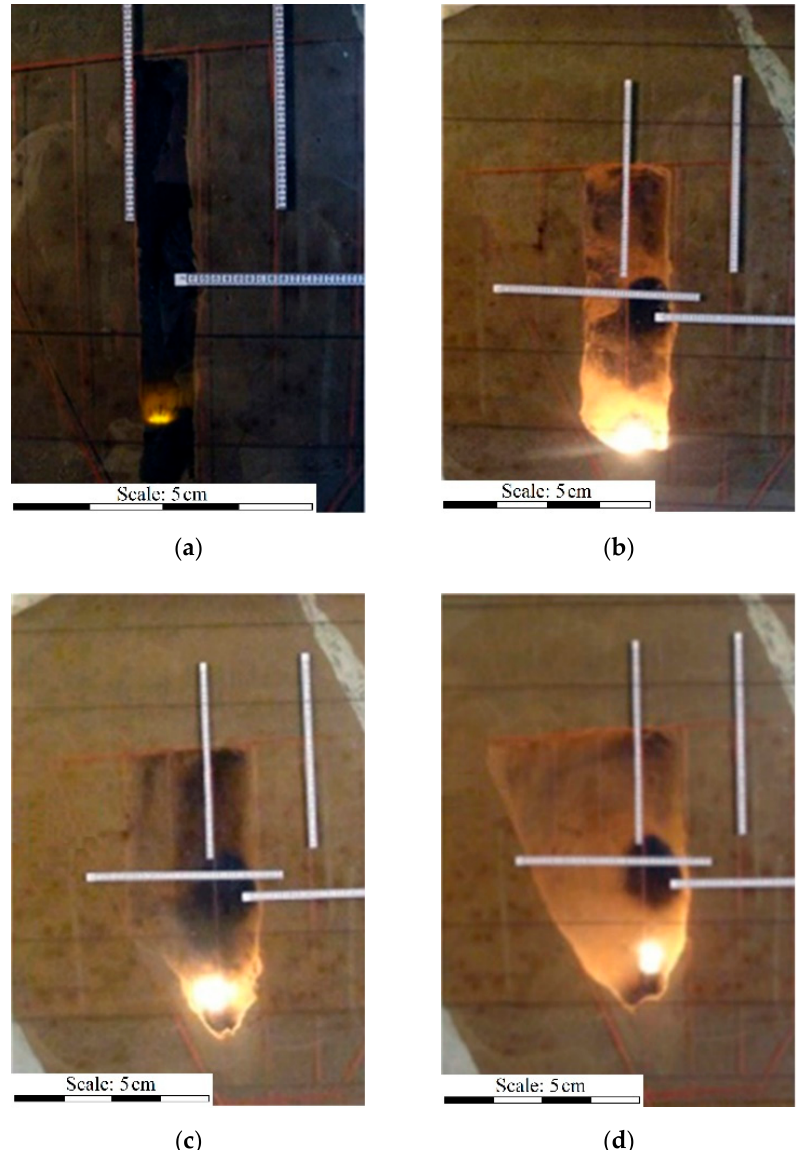
Figure 7. Modeling the stages of foot wall stope mining: ( a ) stage 5; ( b ) stage 6; ( c ) stage 7; ( d ) stage